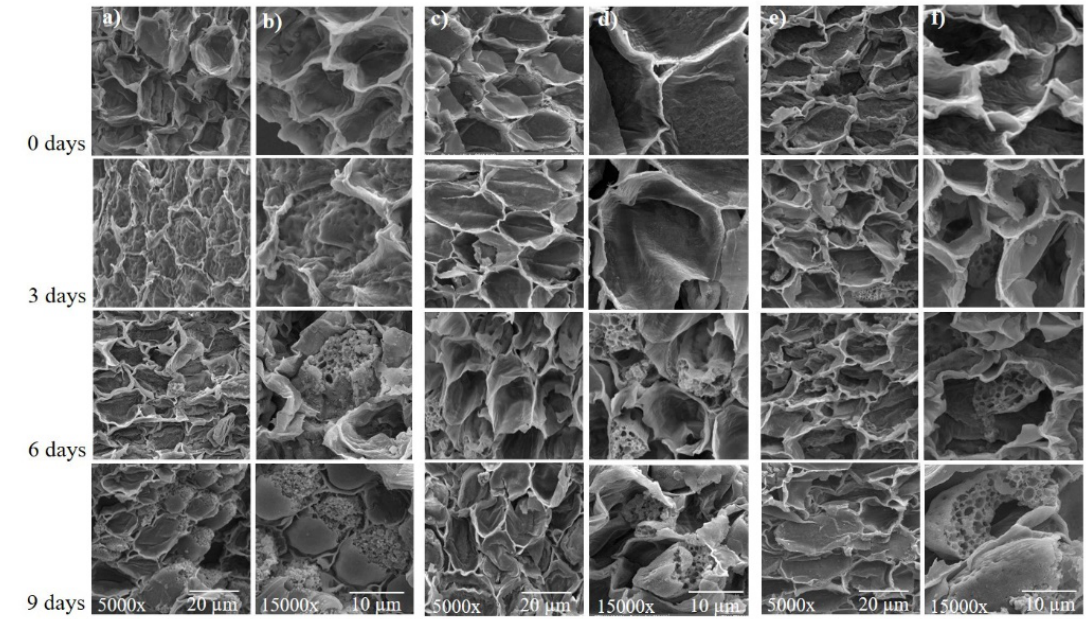
Figure 9. Scanning electron micrographs of the soybean seed embryonic axis of three cultivars (BMX Raio, BMX Zeus, and DM 53i54) exposed to different periods of accelerated aging (0, 3, 6, and 9 days). ( a , b ) BMX Raio; ( c , d ) BMX Zeus; ( e , f ) DM 53i54. The embryonic axis analyzed by cross section.